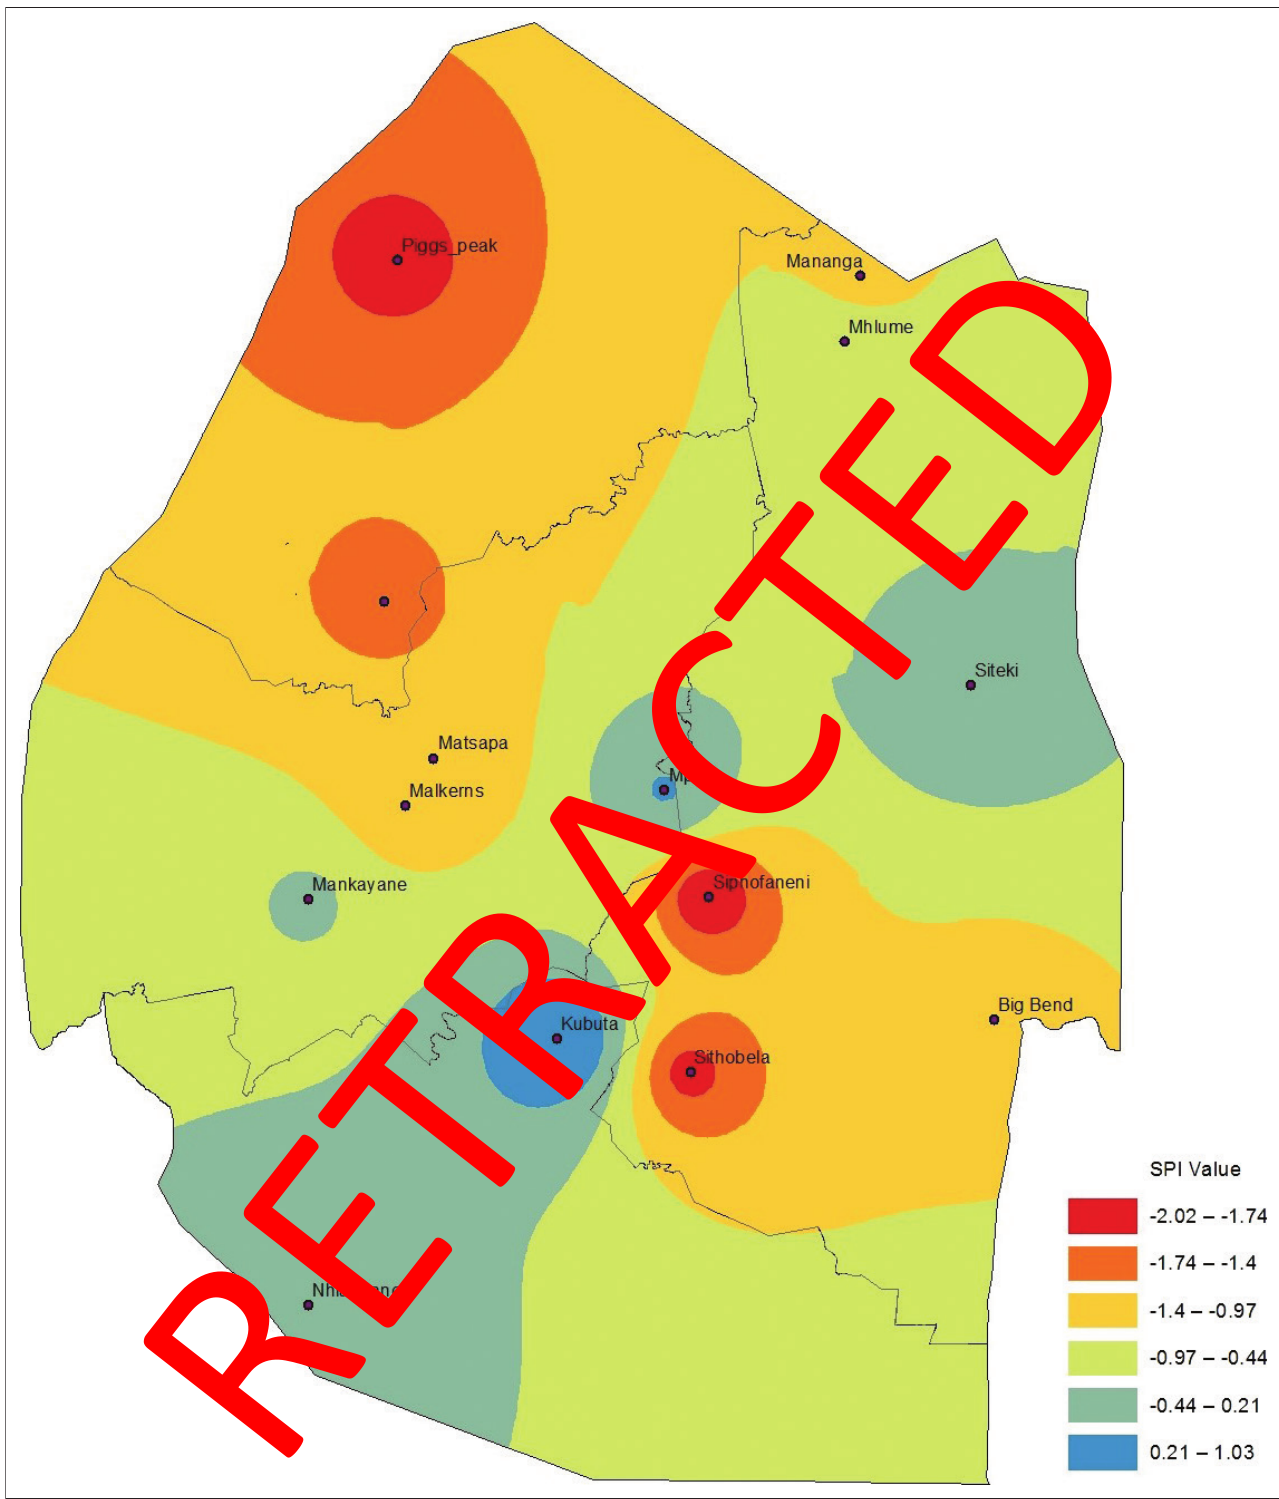
FIGURE 7: Standard Precipitation Index 3-month timescale during 2004–2005. consistent with drought declarations by the government as well as EM-DAT